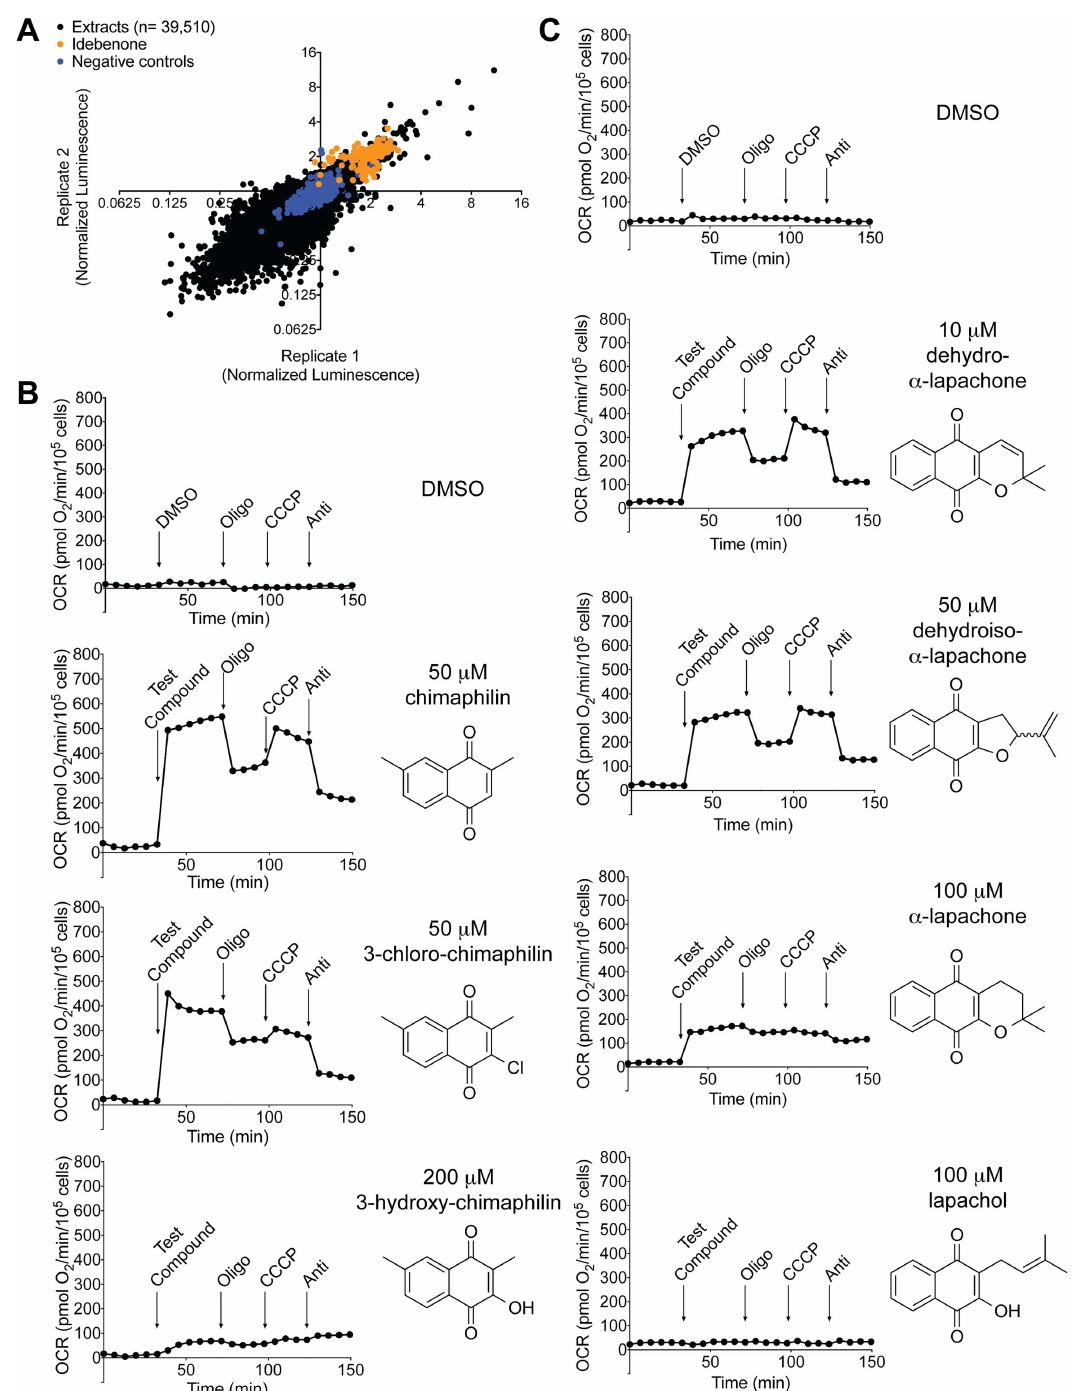
Fig 2. NaturalProduct Screenand Follow-up. (A) Scatterplot of the normalizedluminescence scores for the two original replicatesof the naturalproductscreeningdata fromS1 Table (see S2 Table for data fromthe plates retestedwith and withoutantimycin).The data are plottedon a Log2 scale. The extract plates includedDMSO wells and emptywells, which are plottedas the “negative controls.” The positive controlplates containedwells with 2.4 mM idebenone, which was diluted upon transfer to the cell plate. These points are labeled“idebenone.” (B) Seahorsedata for the threecompounds isolated from Chimaphilaumbellata .(C) Seahorsedata for the four compounds isolatedfrom Sterospermum euphoroides .For (B) and (C),each experiment was performed threetimes and data froma single representative experiment is